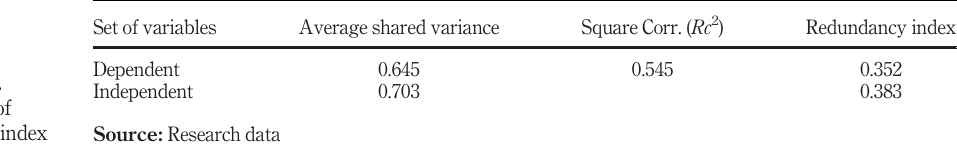
Table XVI. Calculation of redundancy